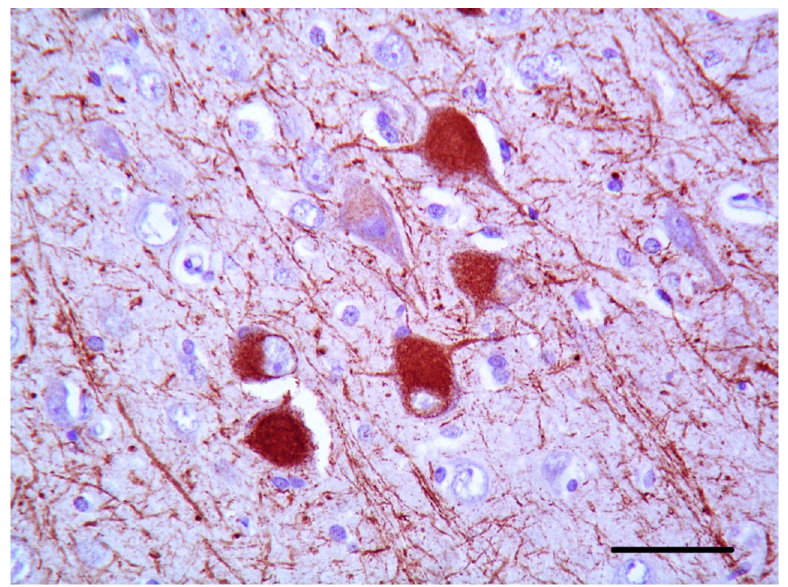
Figure 4. Cerebral cortex of dog 1. Megalic neurons’ cytoplasm strongly expresses phosphorylated neurofilaments (2F11 IHC, bar = 50 μ m).